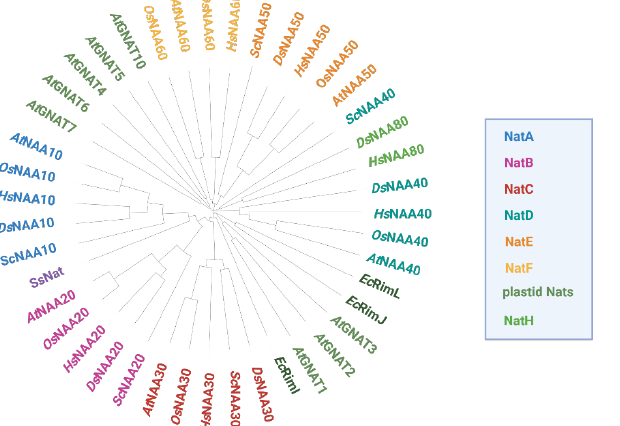
Figure 2. Phylogenetic tree of Nats from different domains of life based on protein sequence comparison. Homologous Nat sequences from the photosynthetic eukaryotes Arabidopsis thaliana (At) and Oryza sativa ( Os ), the non-photosynthetic eukaryotes Homo sapiens ( Hs ), Drosophila melanogaster ( Ds ) and Saccharomyces cerevisiae ( Sc ), as well as the bacterium Escherichia coli ( Ec ) and the archaeon Saccharolobus solfataricus ( Ss ) were aligned with ClustalW. For Os NAA50 and Os NAA60, only one protein could be identified by blasting the respective human orthologs against the rice proteome. The resulting phylogenetic tree was circularized with the iTOL tool (https://itol.embl.de, accessed on 20 October